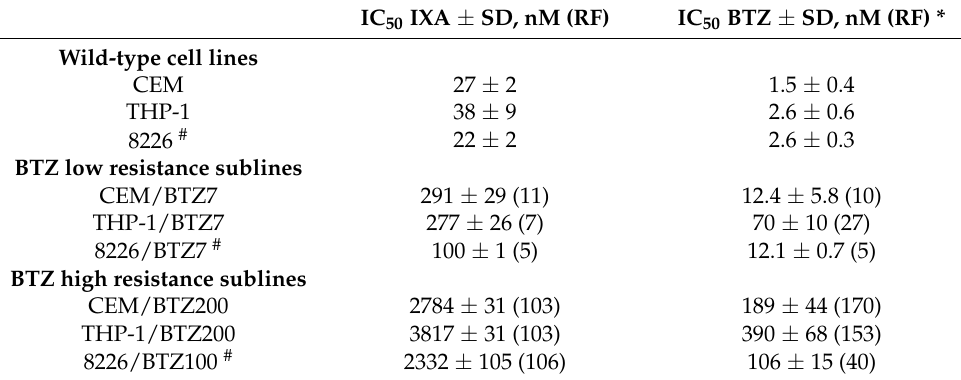
Figure 2. IXA sensitivity of BTZ-sensitive and BTZ-resistant cells. Sensitivity for IXA was assessed after 4-day drug exposure by the MTT cytotoxicity assay in CEM and THP-1 (8226 for comparison 42 ) cells and their low (/BTZ7) and high (/BTZ200 and /BTZ100) BTZ-resistant sublines. Results are expressed as cell growth relative to control cells incubated without drug, set at 100%. Dose–response curves depict the mean ± SEM of three separate experiments. Table 1. Growth inhibitory effects of IXA compared to BTZ in hematological cell lines and their BTZ-resistant